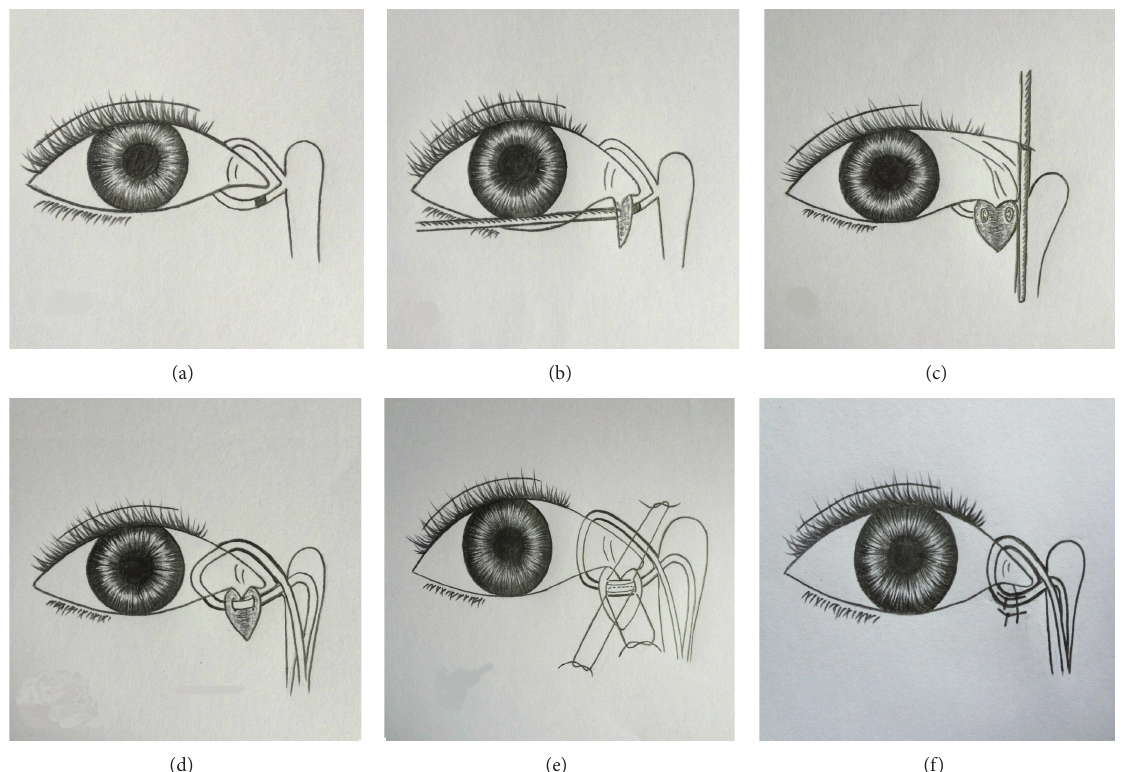
Figure 2: Canalicular repair. A lower canalicular obstruction is shown in (a). A probe is inserted to the obstructed site, and a vertical incision about 5 mm is performed according to the site (b); after inserting a probe from upper canalicular punctum to expose the distal end on a vertical axis of the probe, a pair of scissors is used to cut out scar tissue at the distal canalicular end (c); bicanalicular silicon tube intubation is performed through the reopened canaliculus into nasal cavity (d); 2-3 pairs of sutures are placed around the two ends of canalicular lumen (e); finally, the skin wound is closed with 2-3 stitches